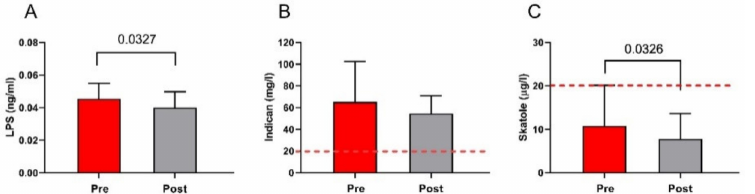
Figure 8. The markers of intestinal dysbiosis and bacterial translocation before and after low FODMAPs diet. Panel ( A ) LPS circualting concentrations; panel ( B ) urinary levels of Indican; panel ( C ) urinary levels of skatole. Data are presented as mean ± SD. Statistical analysis: Wilcoxon matched-pairs signed-rank test with a significant difference set at p < 0.05. The cutoff value is indicated by the red dashed line.